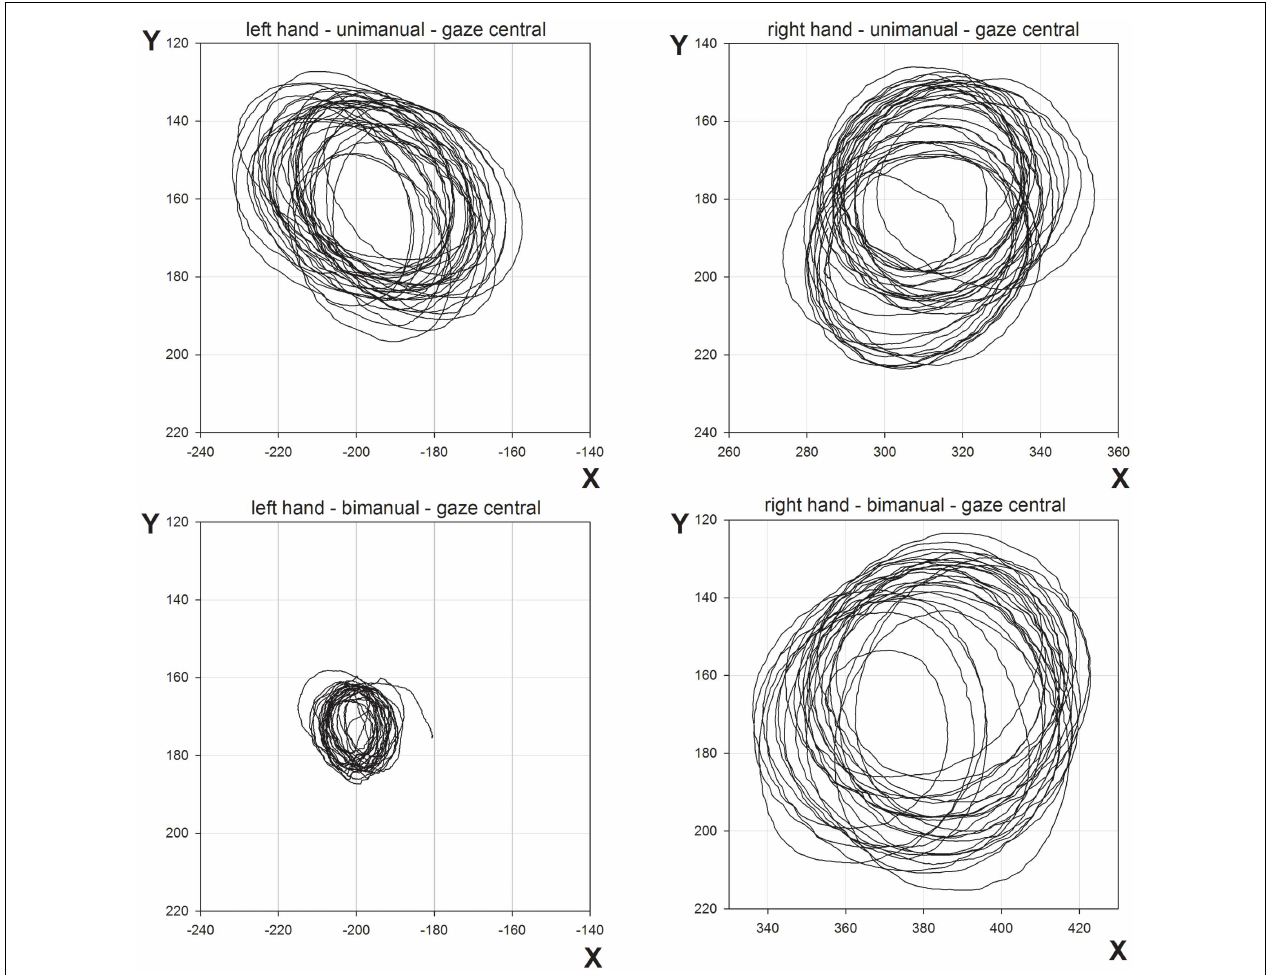
FIGURE 3 | Representative movement trajectories of unimanual and bimanual conditions from Experiment 1, when gaze was directed centrally .